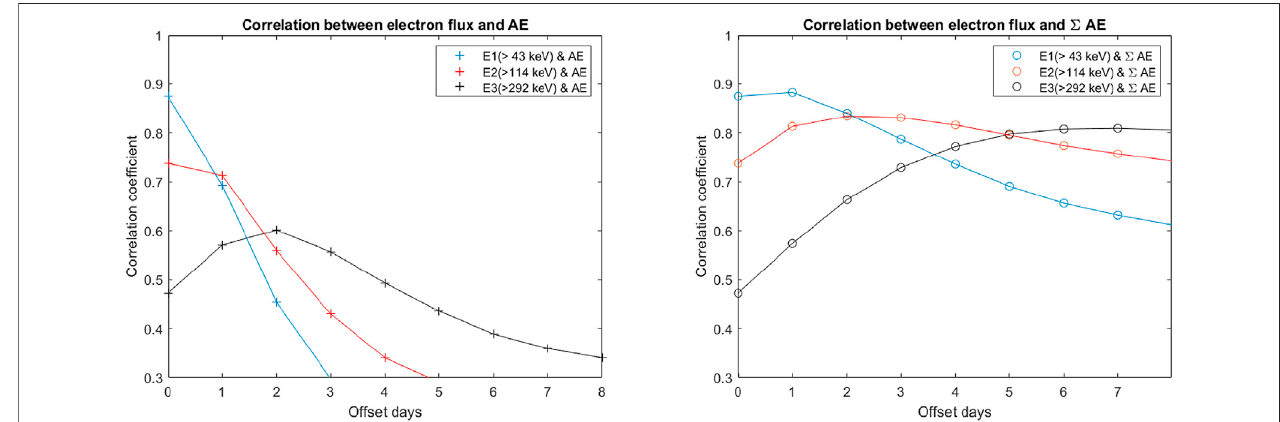
FIGURE 5 | The Pearson correlation coef fi cients between the logarithmic value of the electron fl uxes > 43 keV (blue line), > 114 keV (red line), and > 292 keV (black line) and the logarithmic value of the AE index (left plot) and the logarithmic value of the accumulated AE values (right plot).